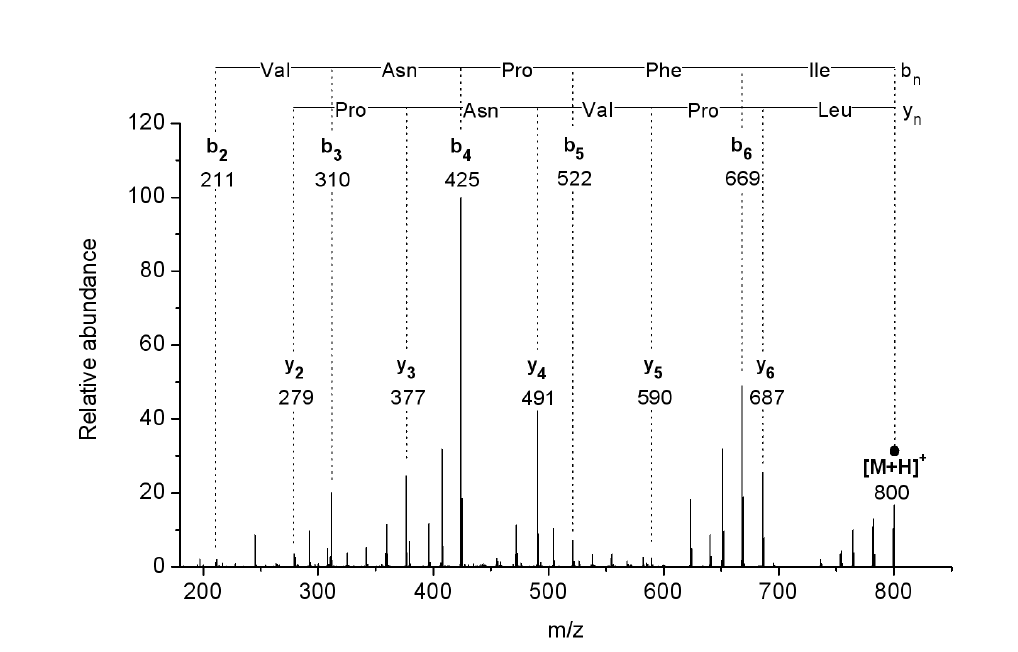
Fig. 1 Product-ion spectrum of the protonated linear peptide generated by one stage of MS/MS. For clarity, just the b and y ions are labeled. The parent ion is marked with “ •